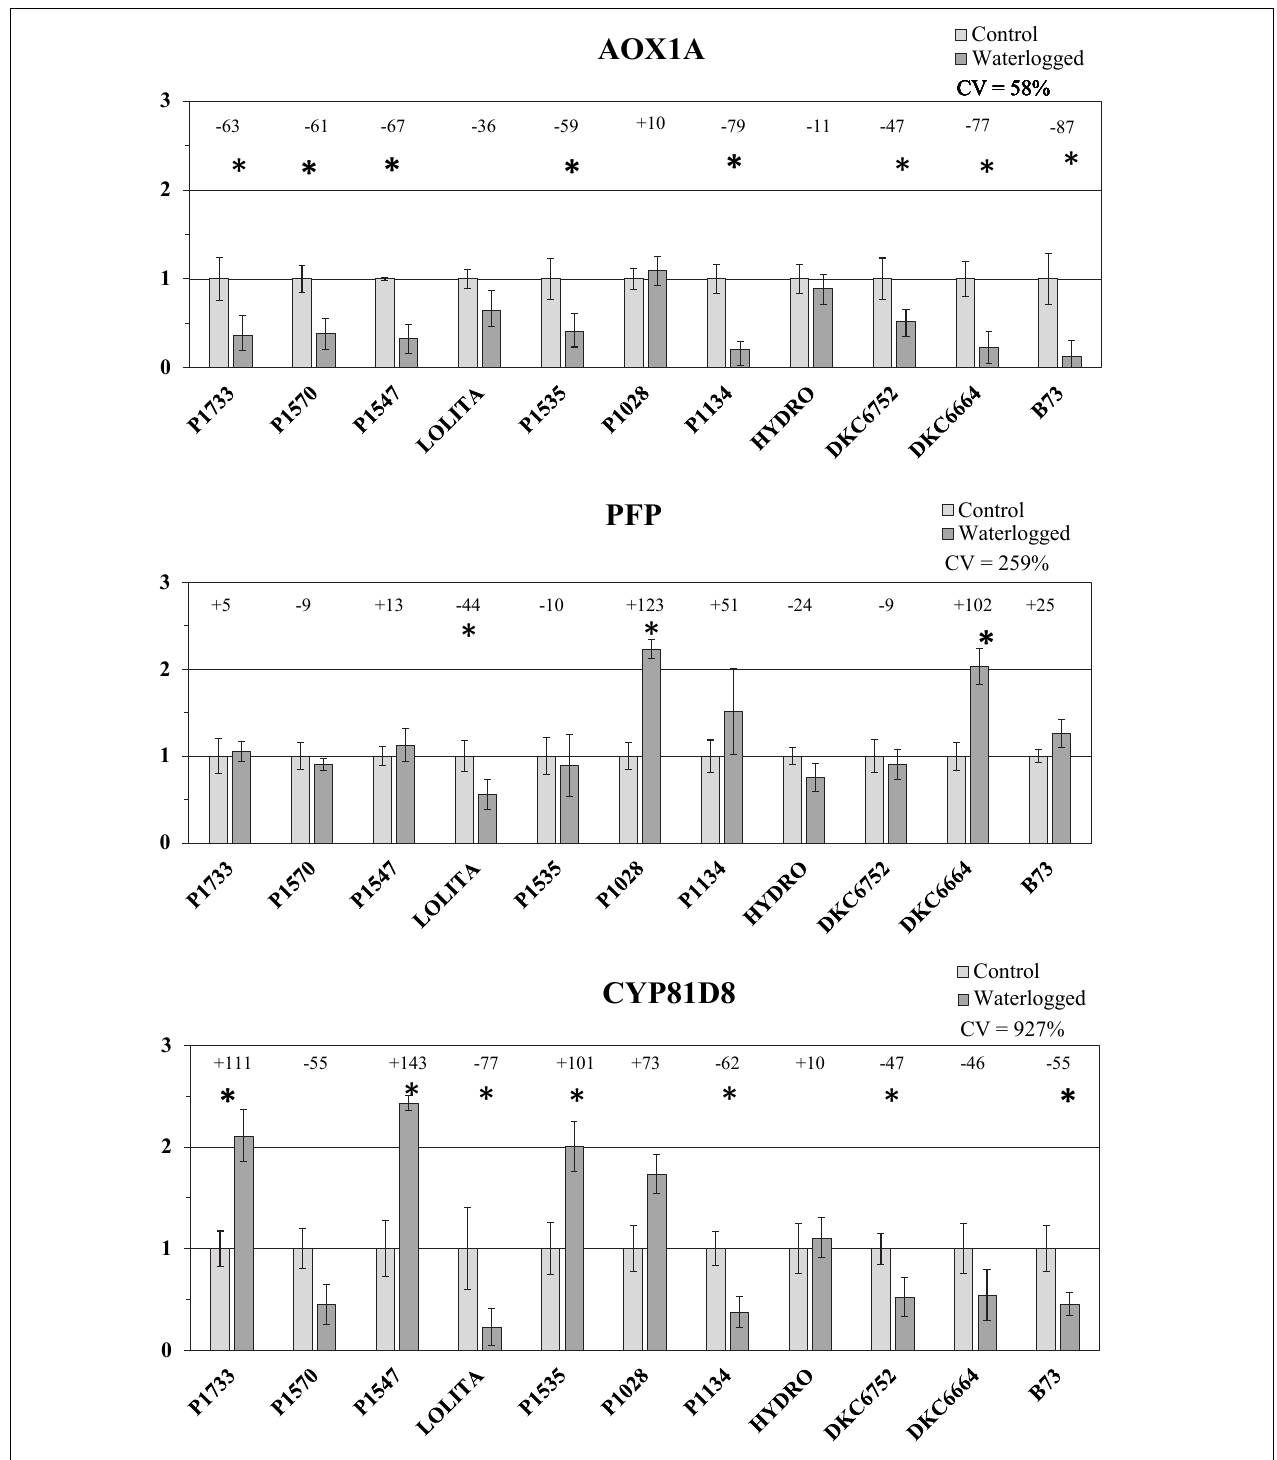
FIGURE 6 | Standardized (on controls) transcript levels of genes CYP81D8, PFP, and AOX1A in waterlogged conditions (average ± SE; n = 3) in 10 representative hybrids and the inbred line B73. Numbers above histograms indicate the percentage variation between waterlogged plants and controls for each hybrid, with asterisks indicating significance ( P ≤